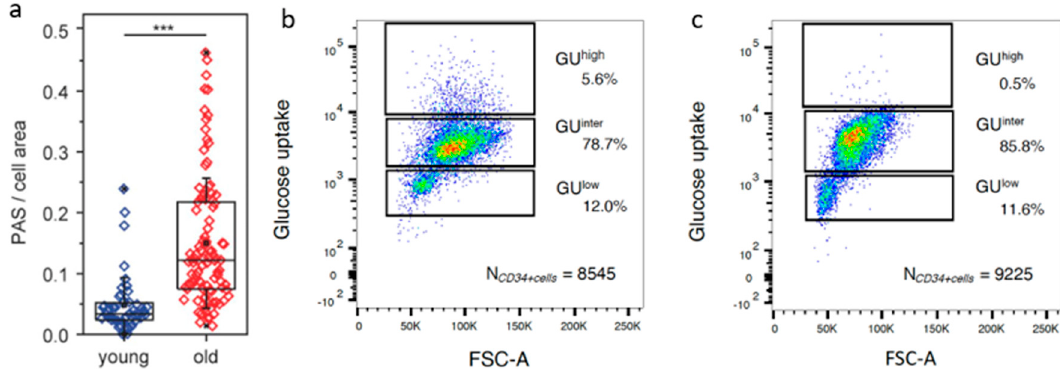
Figure 3. Glycogen accumulation and glucose uptake capacity of the CD34+ HSPC (modified from Poisa et al. [49]). ( a ) Results of the semi-quantitative assessment of intensity of PAS reaction as surrogate marker for glycogen in CD34+ cells from young versus old human subjects. The average glycogen content was significantly higher in old subjects than young subjects < 35 years (one-sided t -test, p = 1.2 × 10 − 6 , *** p < 0.001). ( b , c ) Glucose uptake capacity of the total CD34+ cells was assessed by Cayman’s Glucose Uptake Assay Kit. Incubation for 30 min with 1.75 µ g/mL 2-NBDG yielded a dose-dependent uptake of glucose into the CD34+ cells. The latter could then be separated according to their respective levels of glucose uptake by a FAC-Sorter into three distinct subpopulations according to the glucose uptake (GU) capabilities: GU low , GU inter , and GU high . ( b ) An example of separation of CD34+ cells from a human subject > 50 years according to GU capacity. ( c ) An example of separation of CD34+ cells from a young subject (<35 years). In young subjects only, GU inter and GU low , but scarcely any GU high cells could be detected. Table 1. Fraction of GU high , GU inter , and GU low cells from young ( ≤ 35 years) versus older (>50 years) healthy human subjects. ns: not significant. (Slightly modified from Poisa-Beiro et al. [49]. Young Old p CD34+ Subsets ( n = 3) ( n = 7) in % in % GU high 1.7 ± 1.5 5.4 ± 3.5 0.02 GU inter 66.5 ± 36.9 66.4 ± 22.5 ns GU low 31.8 ± 36.7 28.2 ± 21.7